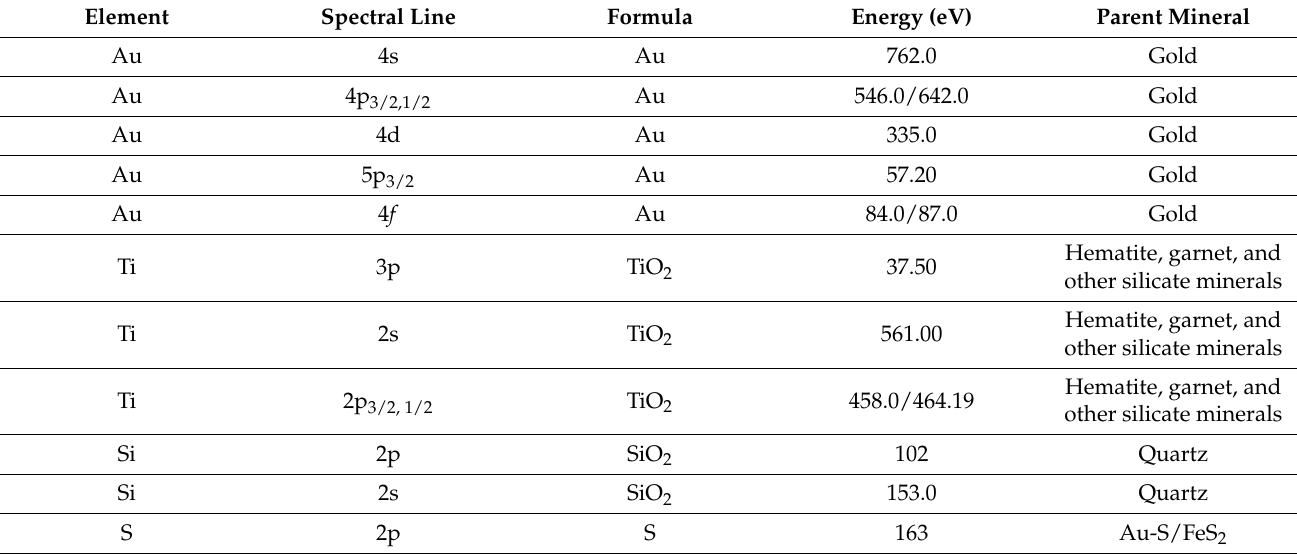
Table 1. Elements identified in the analysis of XPS core levels for Au bulk and powder (untreated, fine-grained, and coarse- grained) Au concentrate samples.